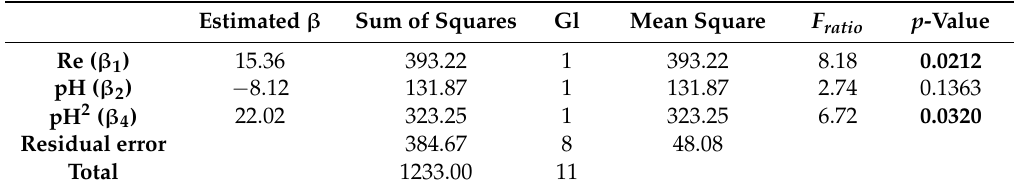
Table 2. Test F based on an analysis of variance of the efficiency degradation of the Reynolds, pH, and quadratic pH